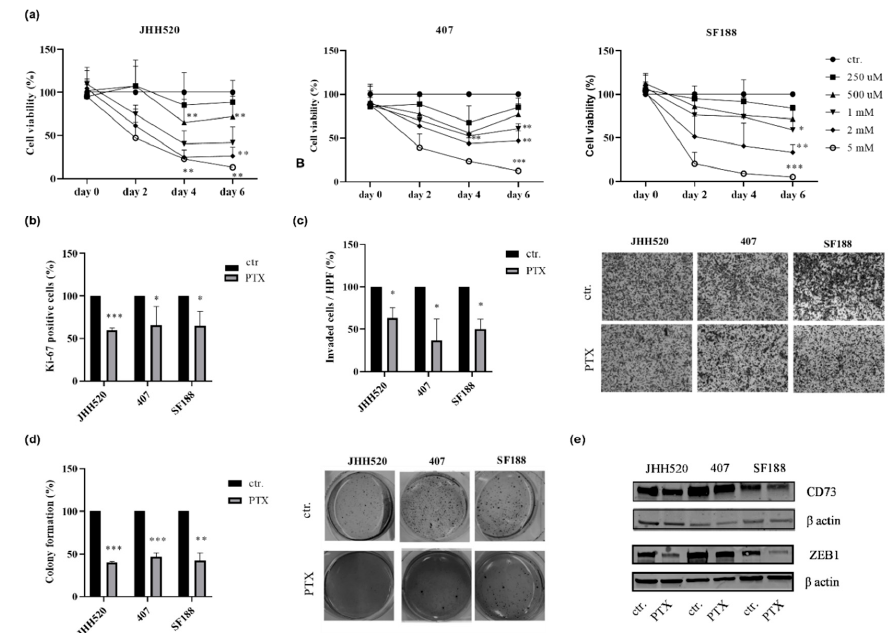
Figure 5. Pentoxifylline (PTX) inhibits ZEB1 and CD73 expression and reduces the viability of GSCs. ( a ) GSC lines (JHH520, 407 and SF188) were treated with increasing concentrations of PTX (250 µM–5 mM) and the percentage (%) of cell viability was assessed compared to control (ctr.). ( b ) The percentage of Ki-67-positive cells was reduced in the PTX-treated cells (JHH520 1 mM, 407 and SF188 2 mM) compared to untreated cells (ctr.). ( c ) The invasive capacity of GSCs was also significantly decreased upon PTX treatment (JHH520 1 mM, 407 and SF188 2 mM) cells (ctr.). ( d ) The clonogenic capacity of cells was assessed by soft agar assays. Treatment with PTX led to a lesser degree of colony formation (JHH520 1 mM, 407 and SF188 2 mM) as compared to untreated cells (ctr.) ( e ) Lower ZEB1 and CD73 protein expression levels were detected using immunoblotting in PTX-treated cells compared to the control cells (ctr.). Abbreviations: HPF, high power field. Statistical significance was calculated with unpaired t-tests. Results are depicted as mean ± SD of three independent experiments performed in triplicate. * p < 0.005, ** p < 0.001, *** p < 0.0001.